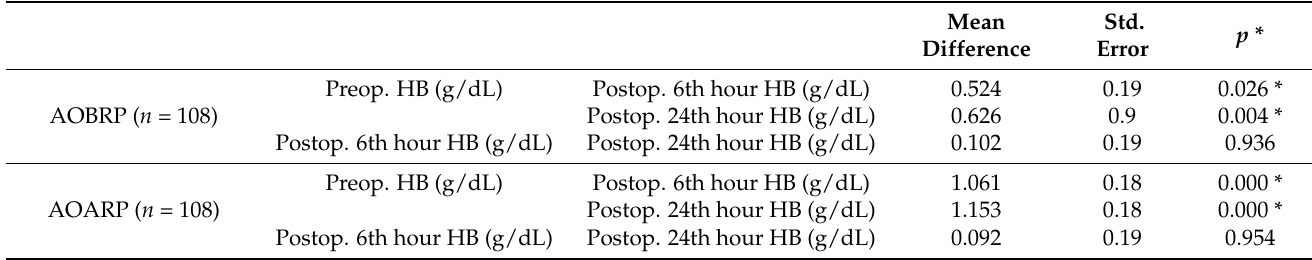
Table 3. Comparison of the hemoglobin levels at different times for each